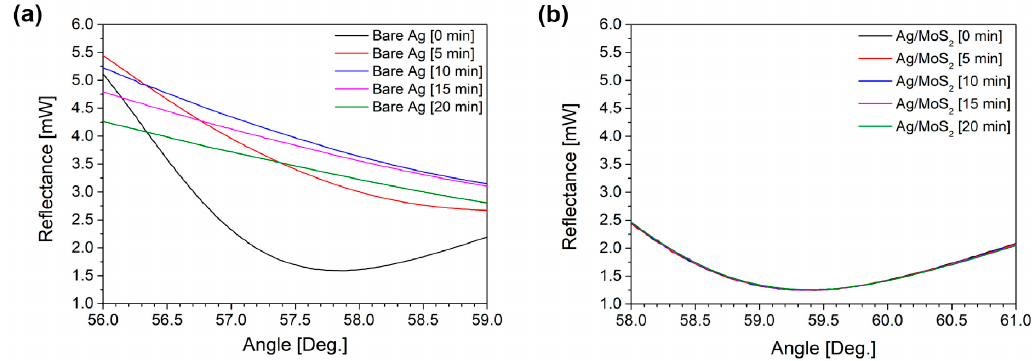
Figure 4. SPR signals of ( a ) bare Ag and ( b ) Ag/MoS 2 substrates in water with laser irradiation. Bare Ag substrate is easily oxidized as soon as it is exposed to a laser light and the SPR curves drastically change. Photosensitive Ag 2 O, which is formed on the Ag surface during the progress of oxidation, decomposes when it is heated and the surface structure is damaged during the formation and decomposition of Ag 2 O.